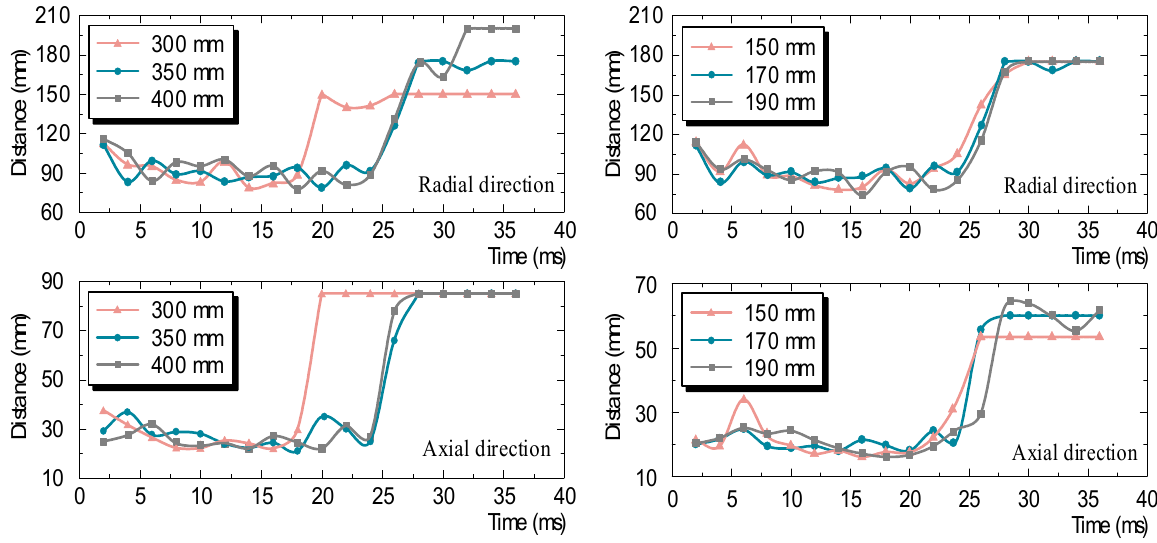
Figure 4. A comparison of the arc diffusion distances for different computational domains.